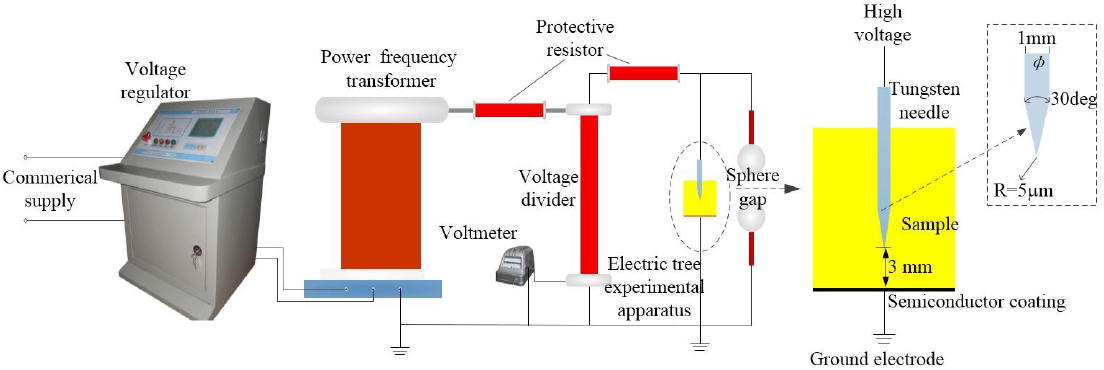
Figure 2. Schematic experimental system of electric tree inception and propagation.